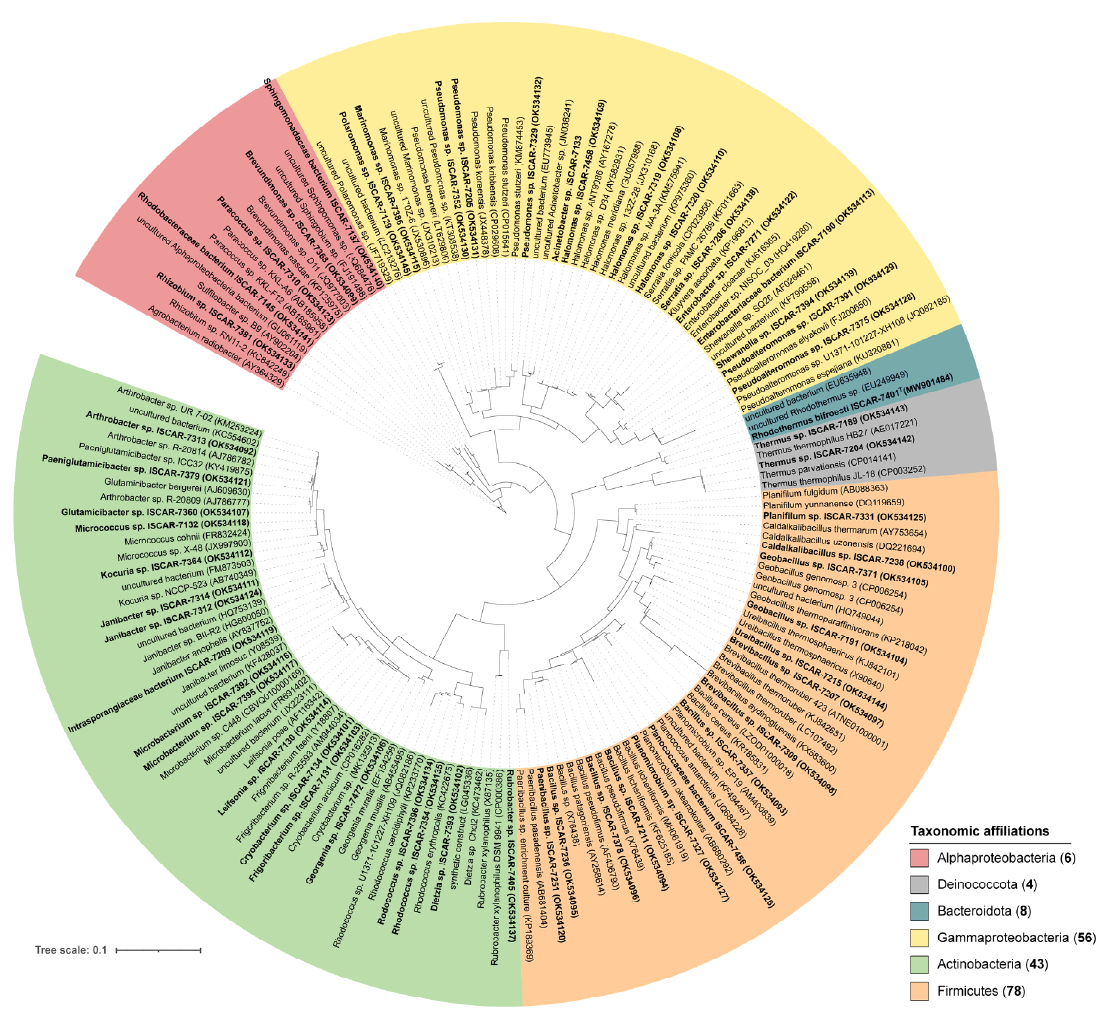
Figure 2. Maximum likelihood phylogeny of the partial 16S rRNA gene sequences placing the cultured bacteria from the subsurface of Surtsey island. The final alignment contained 158 sequences, 55 from this study (in bold), and was generated using the SILVA SINA alignment tool and the SILVA reference alignment. The tree was constructed using RAxML under the GTR GAMMA model of evolution.